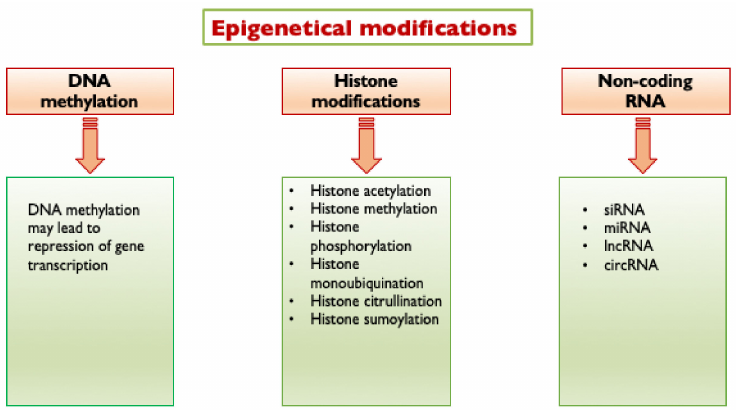
Figure 2. Epigenetic modifications triggered by hyperglycemia. Hyperglycemia triggers the following epigenetic modifications: DNA methylation, histone modifications and non-coding RNA mediated control. siRNA, short interfering RNA; miRNA, micro RNA; lncRNA, long non-coding RNA; and circRNA, circular